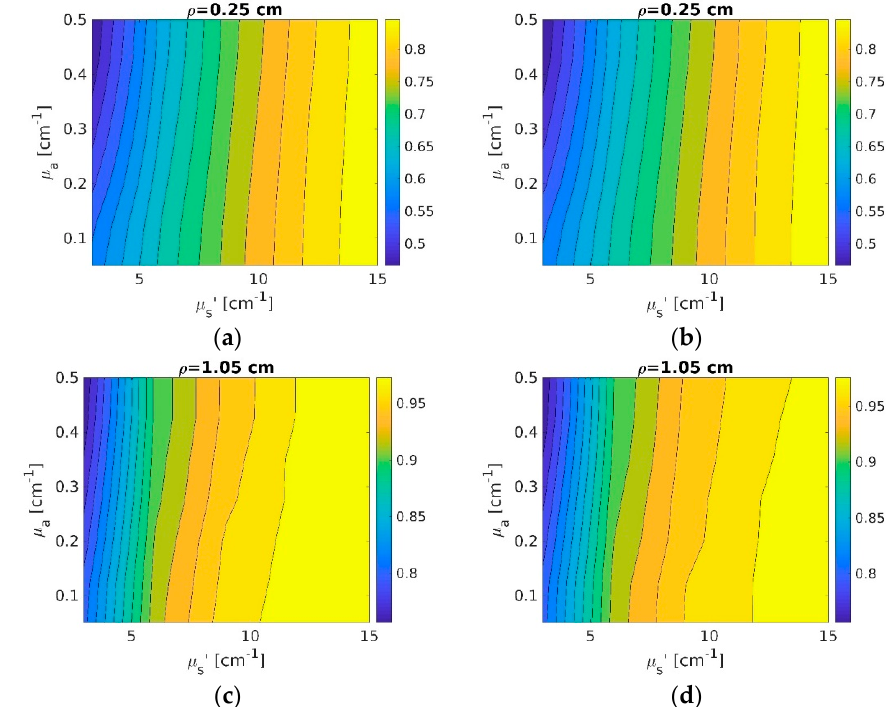
Figure 7. Scaling (correction) factors determined using simulations at two SDS (top: 0.25 cm; bottom: 1.05 cm) shown for two di ff erent media with two di ff erent flow coe ffi cients (left: D B = 1 × 10 − 8 cm 2 / s; right: D B = 3 × 10 − 8 cm 2 / s). Each panel shows data for 35 MC simulations spanning seven µ a and five µ (cid:48) s values (see text). Note that the color-bar scale changes for data in top and bottom rows.